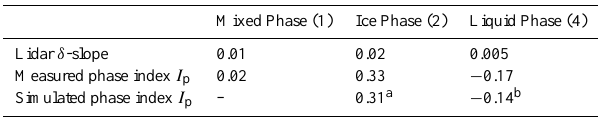
Fig. 6. (a) Vertical profile of r eff and water contents. (b) Single scattering albedo ˜ ω as derived from Mie-calculation for liquid water and taken from the Baum parametrization for ice particles, and (c) phase index profile. Table 2. Comparison of phase indices and lidar depolarization slopes.